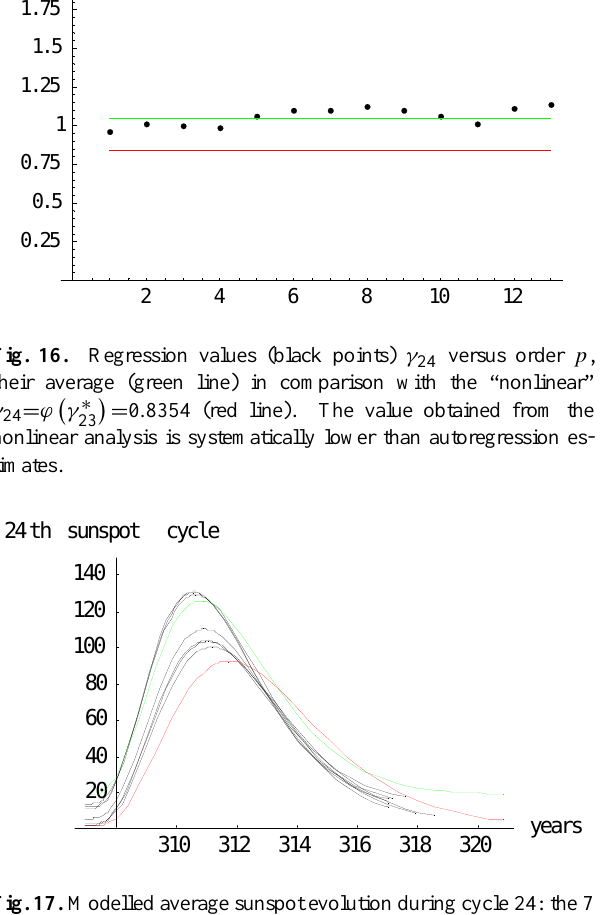
Fig. 17. Modelled average sunspot evolution during cycle 24: the 7 black curves and their average (green curve) result from the autore- gression method, while the red curve is obtained using the nonlin- ear mapping technique. Comparatively, the latter curve suggests a lower maximum of about 90, which also peaks about one year later.